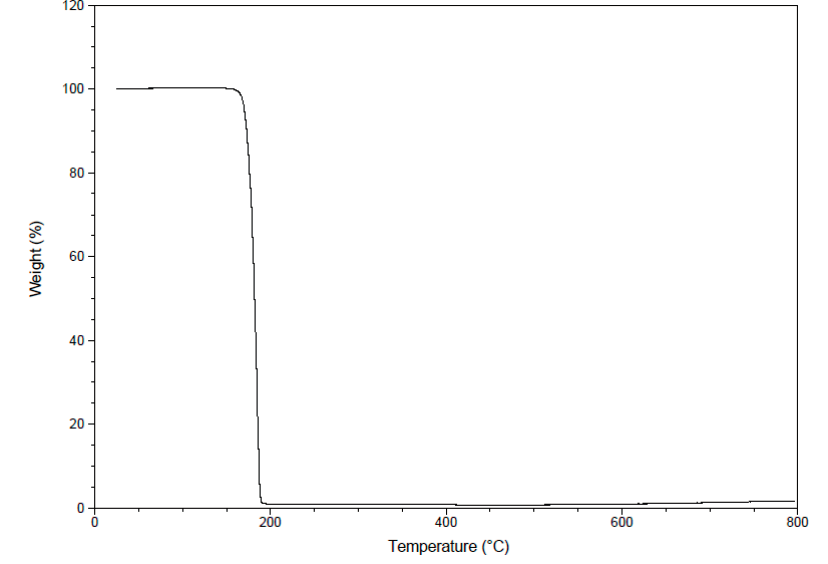
Figure 10. The TGA curve of the studied compound.